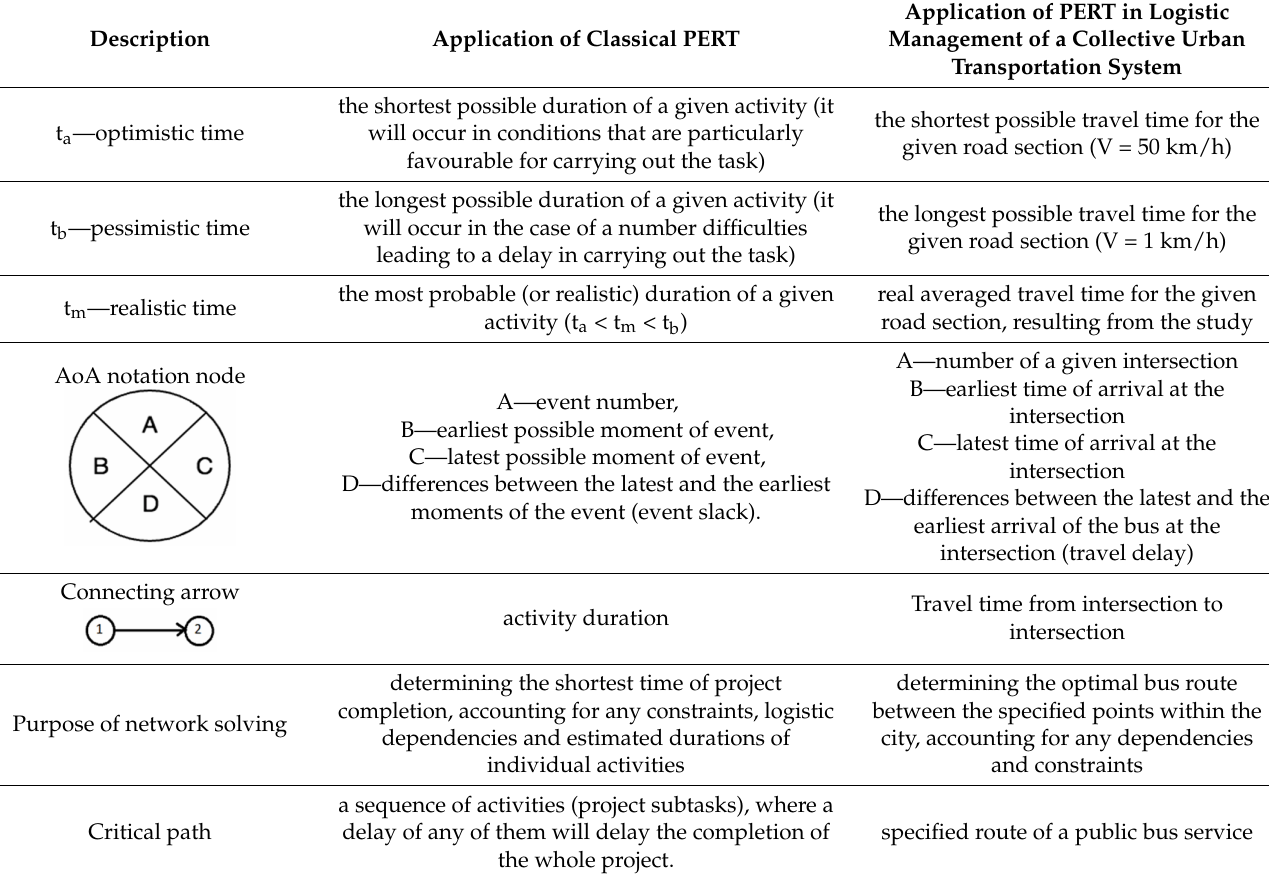
Table 1. PERT in management of collective urban